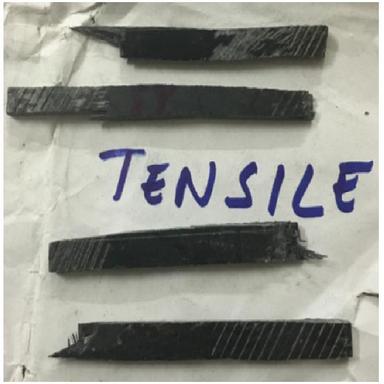
Specimen after Tensile Test.